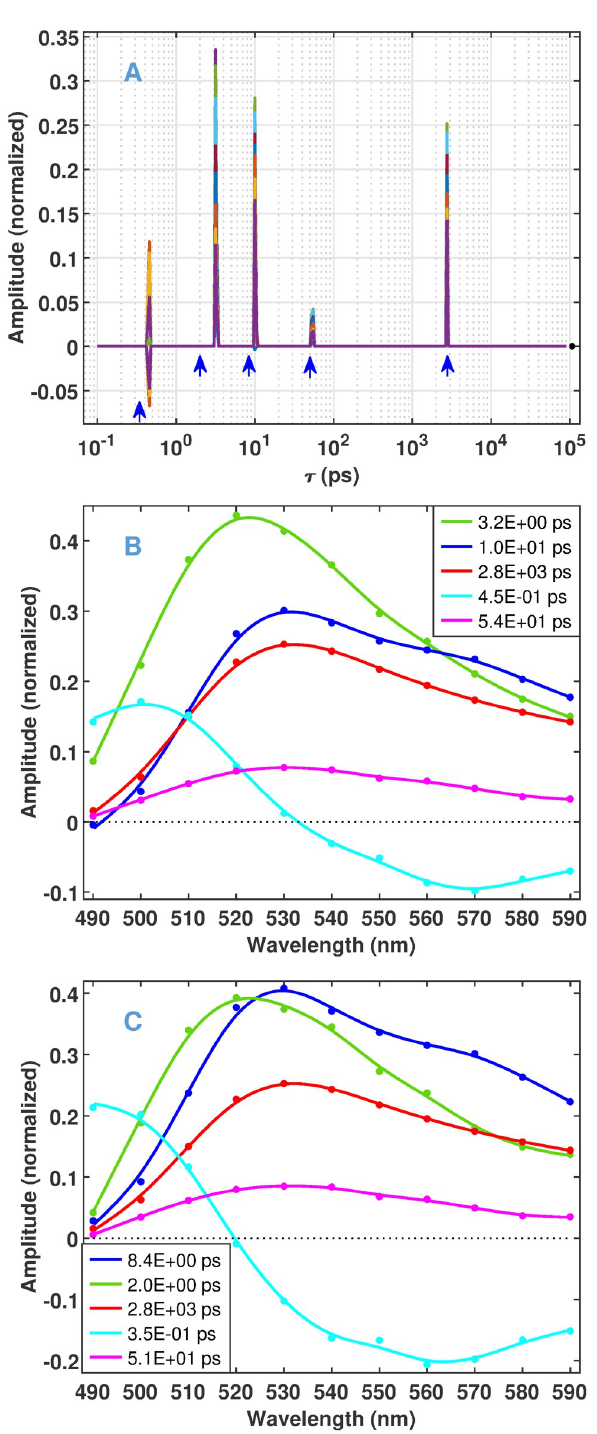
Fig 7. Fluorescence kinetic parameters predicted by the selected models presented in Fig 6. For details see the caption of Fig 4. In (B) and (C) the continuous lines are smoothing splines over the data plotted by dots.